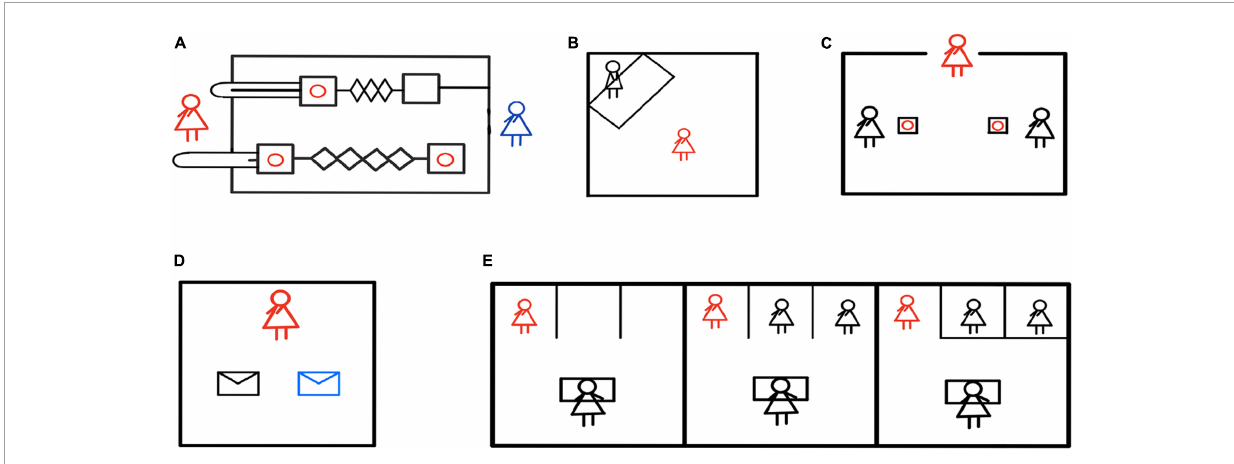
FIGURE3 Helping behavior experiments in human early childhoods. (A) The red figure represented the toddler actor, and the blue figure represented the toddler receiver. The red circle was the reward. The actor could choose to pull the lower pro-social pull rod, which would benefit both themselves and the receiver, or the upper pro-self pull rod, which would only benefit themselves. The experiment found that 2.5-year-old toddlers pulled more pro-social levers, indicating a preference for pro-social behaviors (Sebastián-Enesco et al., 2013). (B) The red figure represented the infant actor, and the black figure represented the experimenter. The experiment observed the infants’ instrumental helping behavior when the experimenter pretended that something had fallen and required assistance. The study found that additional rewards decreased the infant’s helping behavior (Warneken and Tomasello, 2008). (C) The red figure represented the actor, and the black figure represented the receiver. The experiment investigated whether children would help their friends or peers when given a choice to assist only one. The results revealed that young children helped their friends more but also helped their non-friend peers (Engelmann et al., 2019). (D) The red figure represented the actor, who had ten stickers that could be kept or given away. The stickers that the actor kept were put in white envelopes, while the stickers given to others were put in blue envelopes. The results indicated that both autistic and neurotypical children demonstrated altruistic tendencies (Peterson and Wellman, 2022). (E) The red figure represented the actor, the black figure at the table represented the experimenter, and the other black figure was the bystander of the same age as the actor. The experimenter pretended to spill water and required assistance. There were no bystanders in the left picture, two bystanders in the middle picture, and two bystanders in the right picture (but there were obstacles preventing them from helping the experimenter). The results showed that children were more likely to help the experimenter when there were no bystanders or when bystanders were unable to help (Plötner et al.,